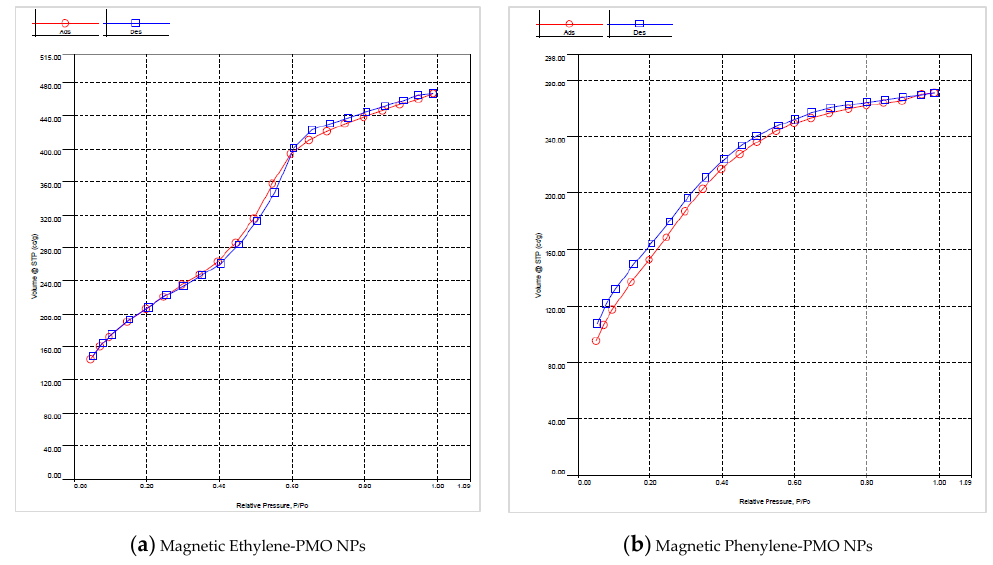
Figure 11. N 2 adsorption-desorption isotherms of ( a ) M-Ethylene PMO NPs and ( b ) M-Phenylene PMO NPs.